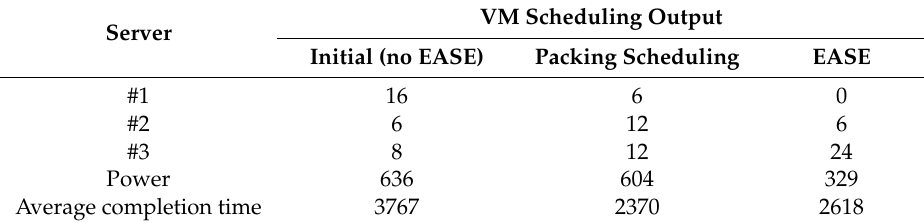
Table 10. Power consumption and performance comparison of heterogeneous cluster.